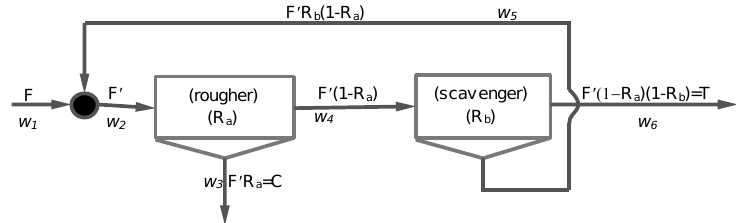
Figure 2. Example of rougher-scavenger circuit for circuit function calculation.